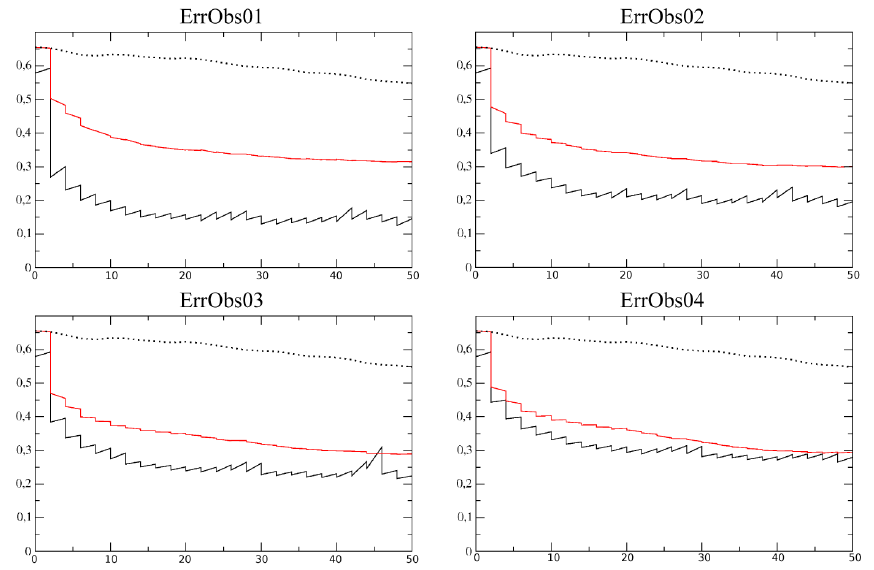
Fig. 4. Influence of temperature observation error on the error statistics. Red curve represents the true RMS error on temperature and black curve the error estimated with the filter (y-axis: day of the experiment, x-axis: RMS error, in ◦ C). The black dotted curve shows the RMS error of FALSE. Each figure corresponds to a different parametrisation of temperature error in R . Values are specified in Table 1.